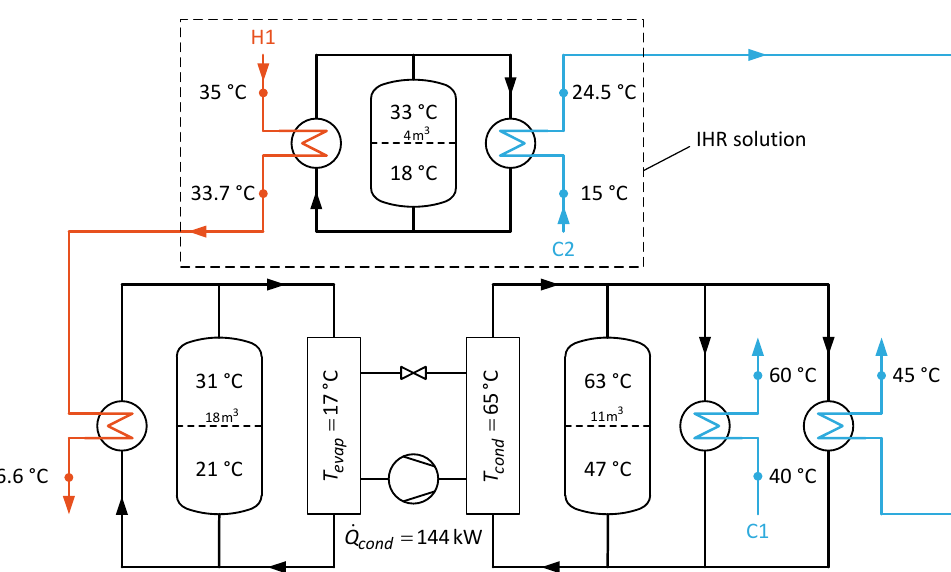
Figure 8. Schematic of solution for Variant 2: Split IHR and HP system with IHR of 80 kWh, including solution for Variant 1 highlighted as the IHR solution.